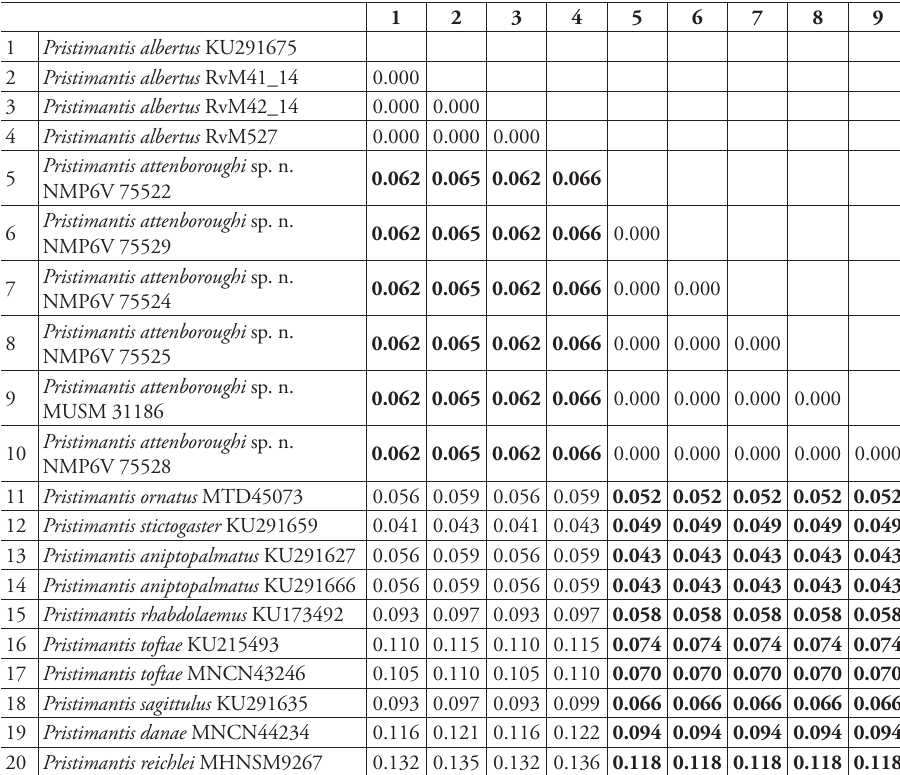
Table 2. Uncorrected p-distances of the 16s mitochondrial rRNA gene for six specimens of Pristimantis attenboroughi sp. n. (in bold) and other Pristimantis species from